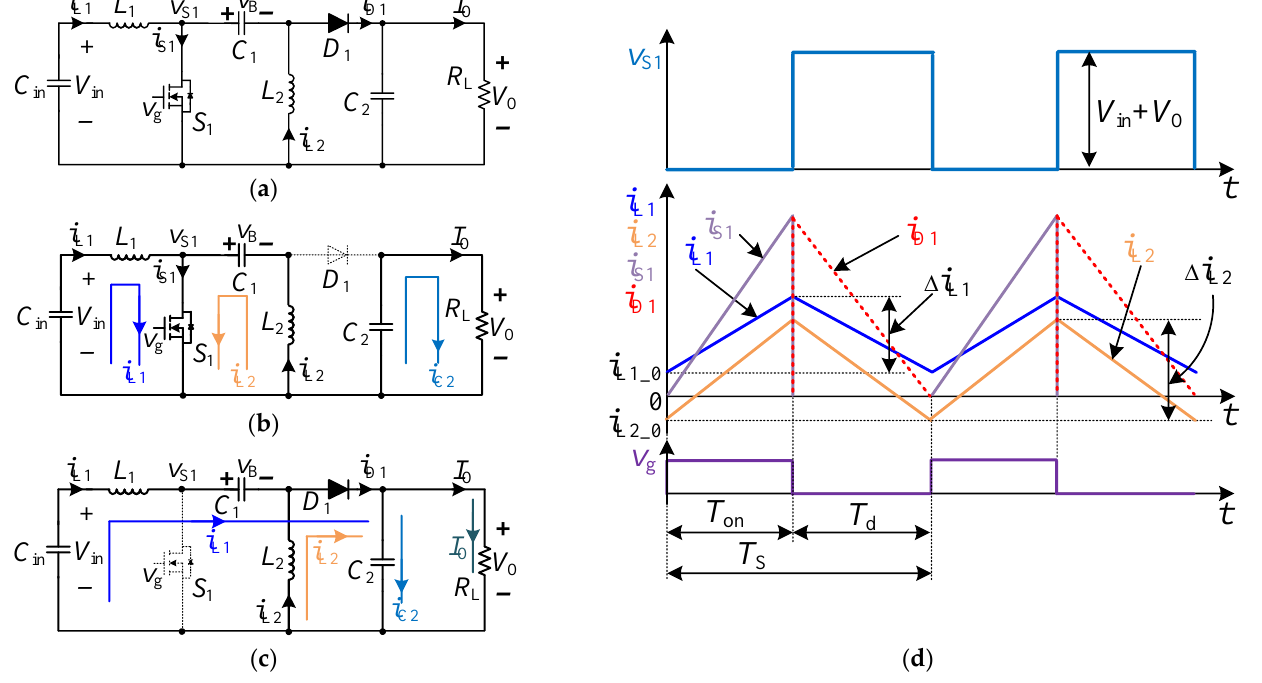
Figure 1. The circuit diagram, equivalent circuits, and key waveforms of BCM SEPIC DC-DC converter. ( a ) Circuit diagram of SEPIC DC-DC converter topology; ( b ) Equivalent circuit when S 1 is on; ( c ) Equivalent circuit when S 1 is off; ( d ) Key waveforms during a switching cycle.